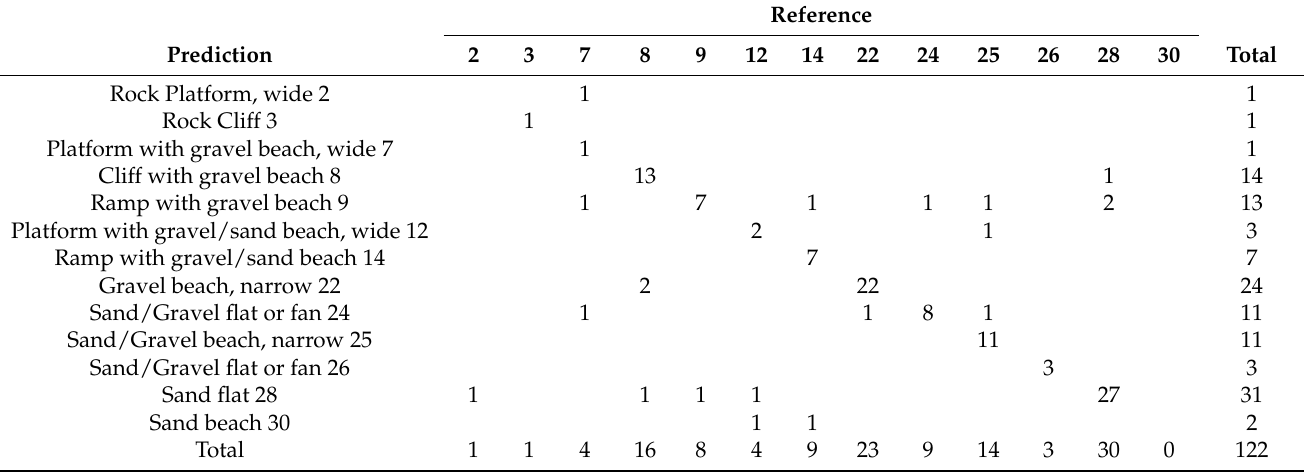
Table 5. Confusion matrix of test samples using optimal features predicted, overall accuracy: 83.61%.